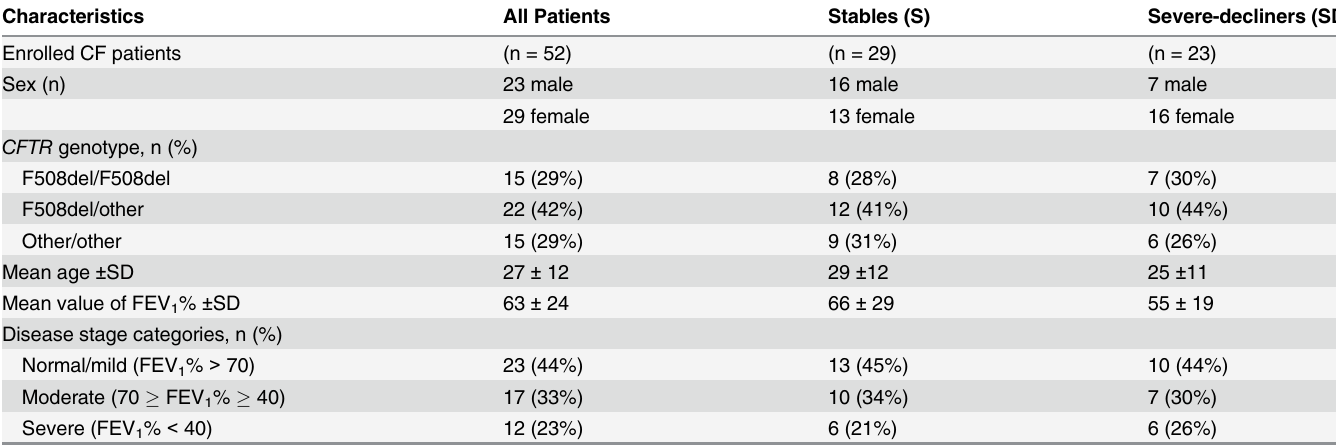
Table 1. Demographic and clinical characteristics of patients enrolled in the